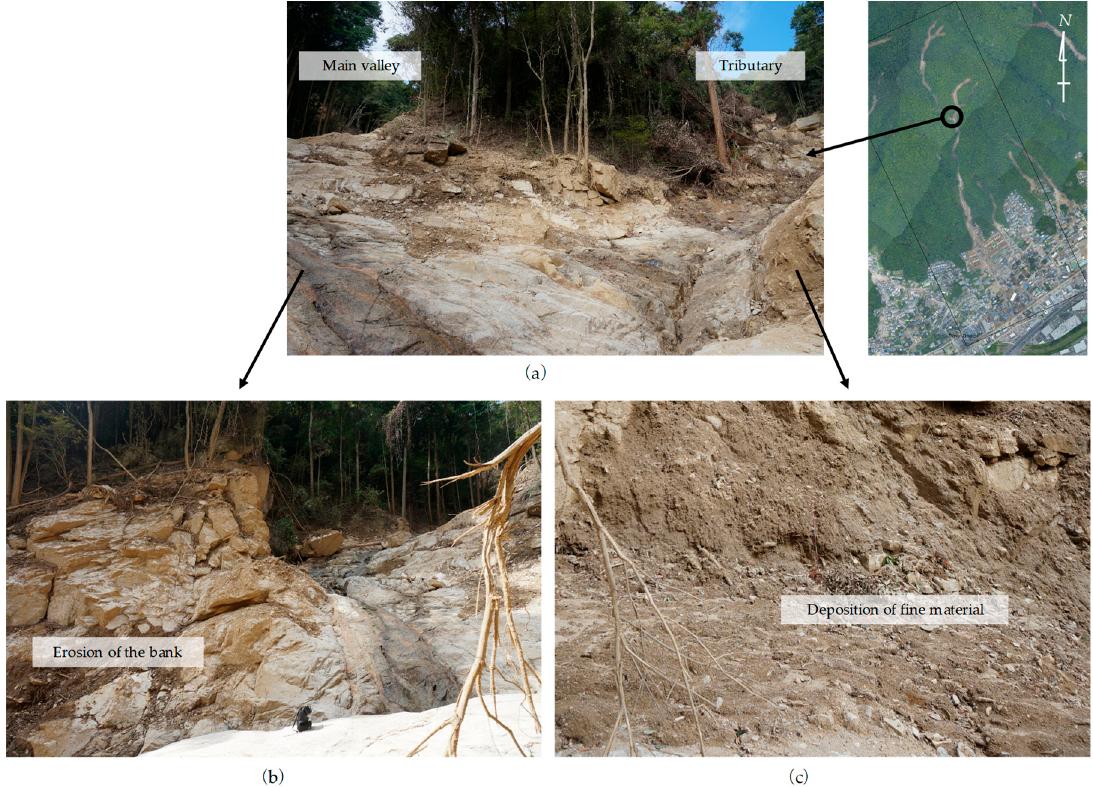
Figure 10. Confluence of the main valley and the tributary. ( a ) Confluence of the main valley and the tributary. ( b ) Right bank at the confluence. ( c ) Left bank at the confluence.